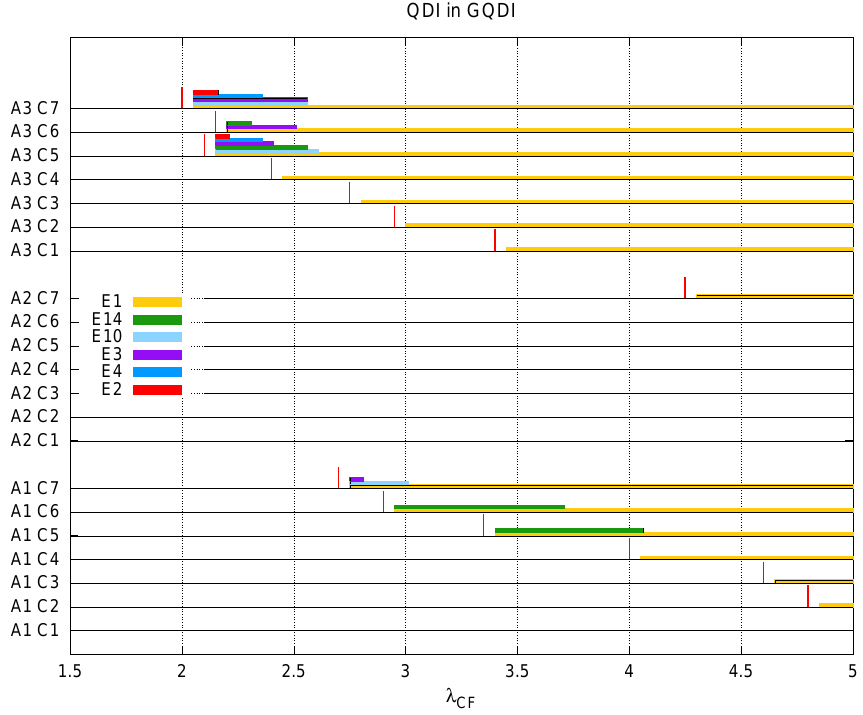
Fig. 6. For every TEDA configuration (i.e. for each method and parameter combinations), the Group Quality Detection Intervals (GQDI, see Eq. 6a) are given (in orange). In addition the intervals QDI of the detected events are plotted but only when they overlap with the GQDI. We observe that the QDI plot of the event E1 would coincide identically with the GQDI for all configurations. From this figure one can deduce easily both the gain function GF( λ CF ) as well as the Detection Tsunami Ranges DTR. In the text particular attention is given to the range DTR(5). Vertical red bars indicate the last value of the tested λ CF for which NF 6=